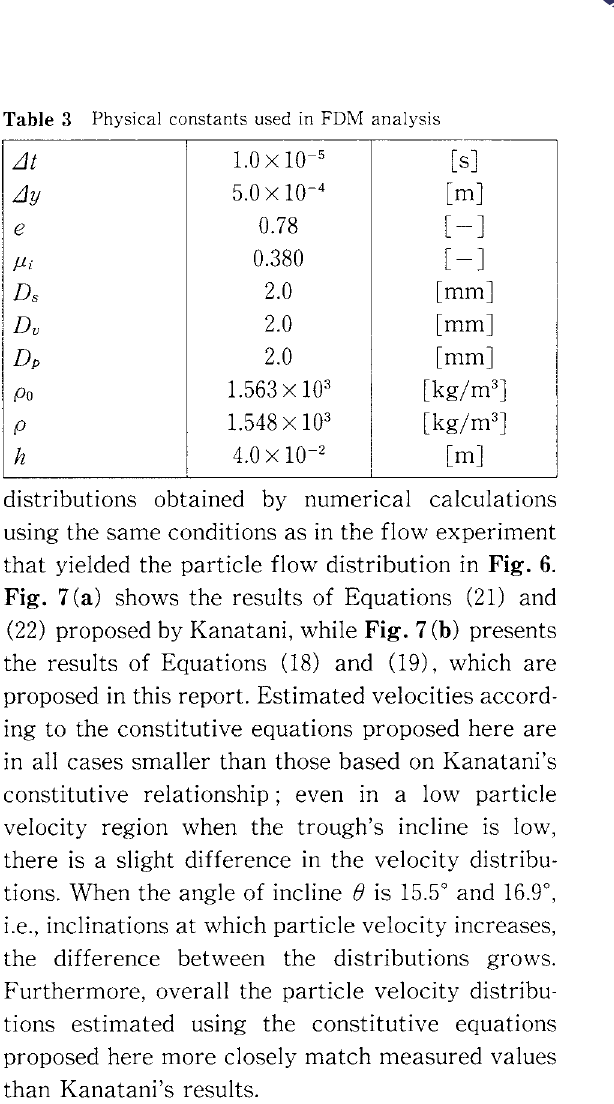
Table 3 Physical constants used in FDM analysis